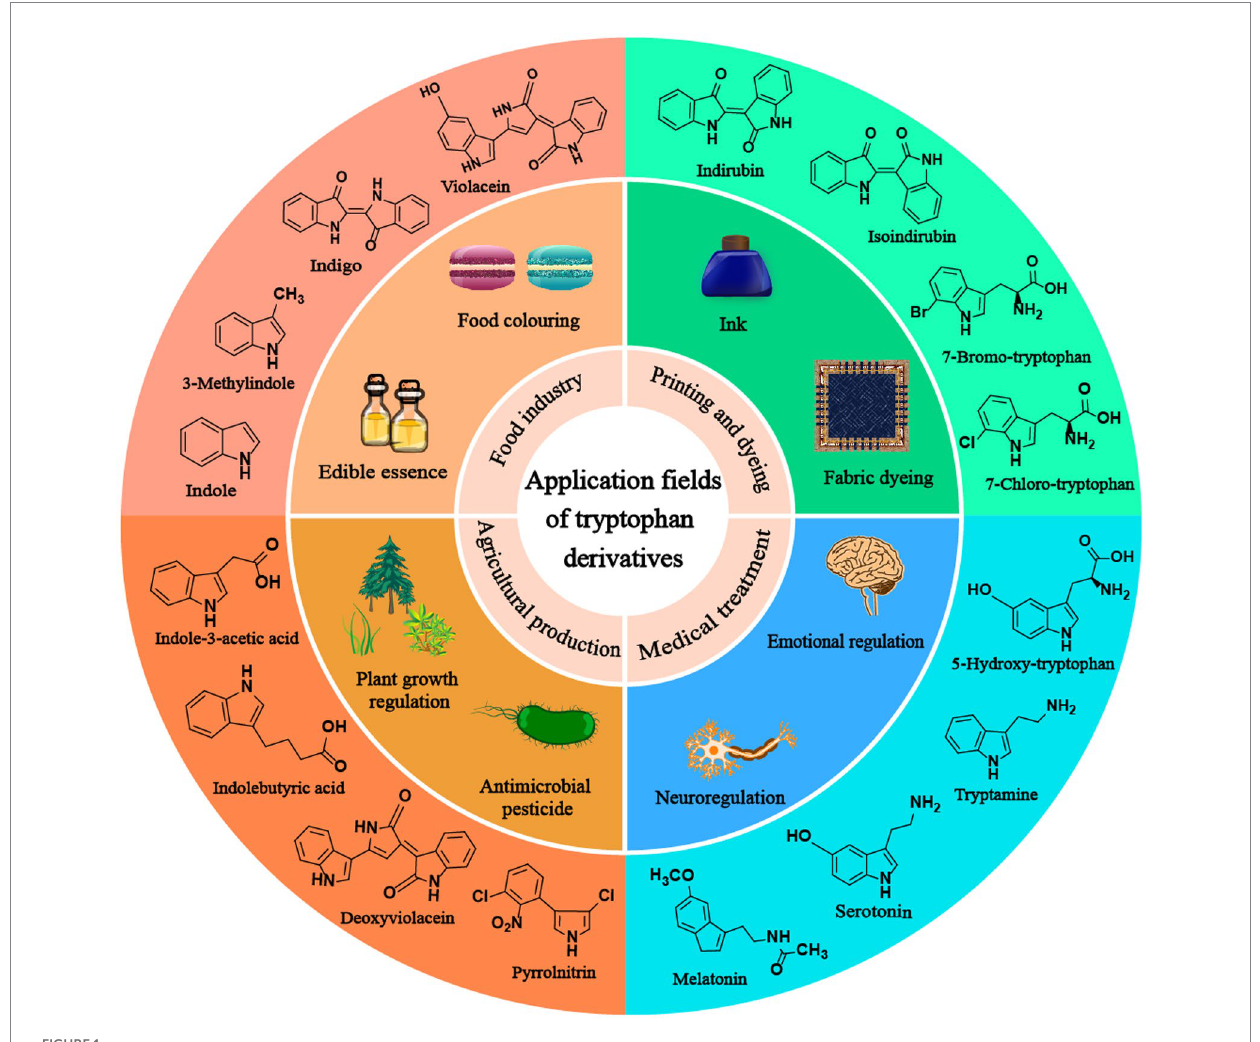
FIGURE 1 The application of tryptophan derivatives in various